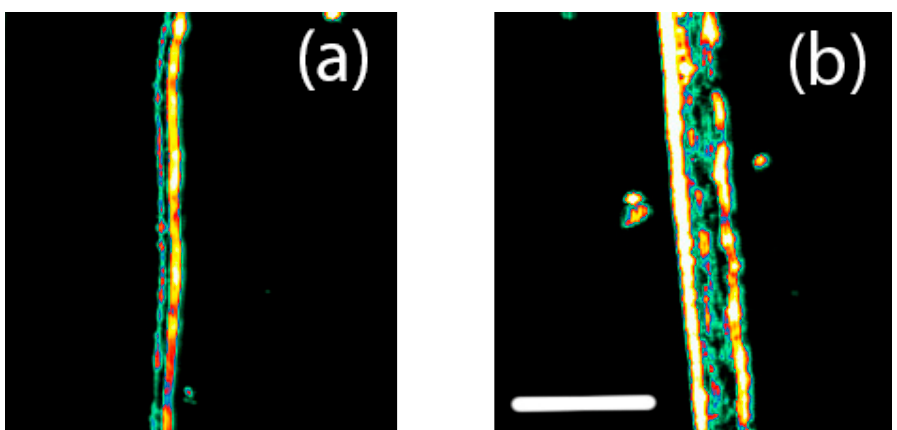
Figure 3. Ultrasonic B-scans of ( a ) bovine amnion and ( b ) equine chorioamnion (amnion on the left of the image, chorion on the right). Scale bar: 500 µm. The sensor measured from the lefthand side of the image.